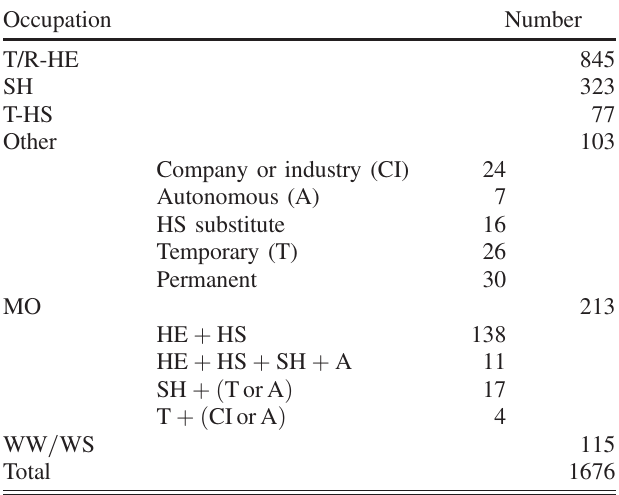
TABLE VI. Occupational profile of respondents. Abbreviations same as in Fig. 7.